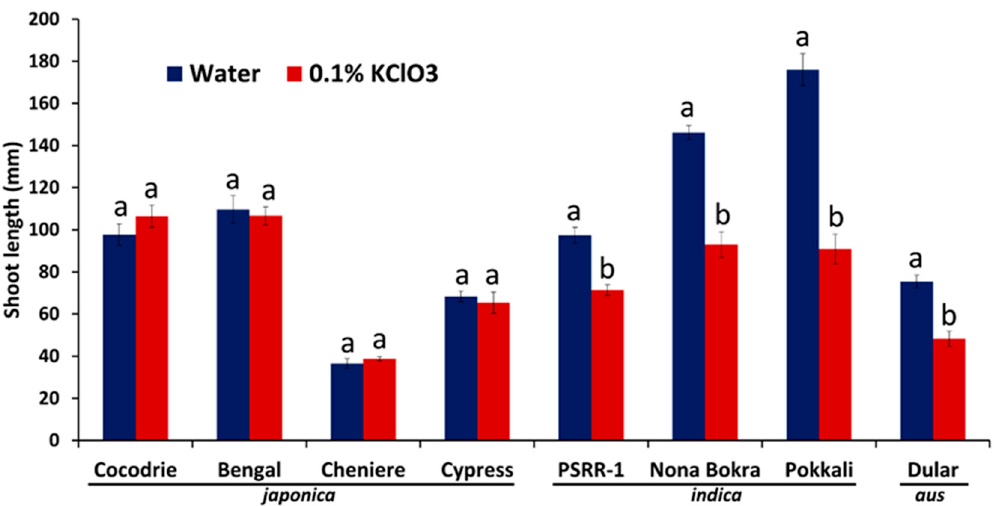
Figure 1. Effect of chlorate uptake on plant height in eight rice genotypes (Cocodrie, Bengal, Cheniere, Cypress, PSRR-1, Nona Bokra, Pokkali, and Dular). The mean seedling heights and standard errors were based on 10 control and 0.1% KCl03-treated seedlings per genotype. Groups are determined by a one-way analysis of variance relative to the respective control at p < 0.05. Means with similar letters indicate no significant difference.